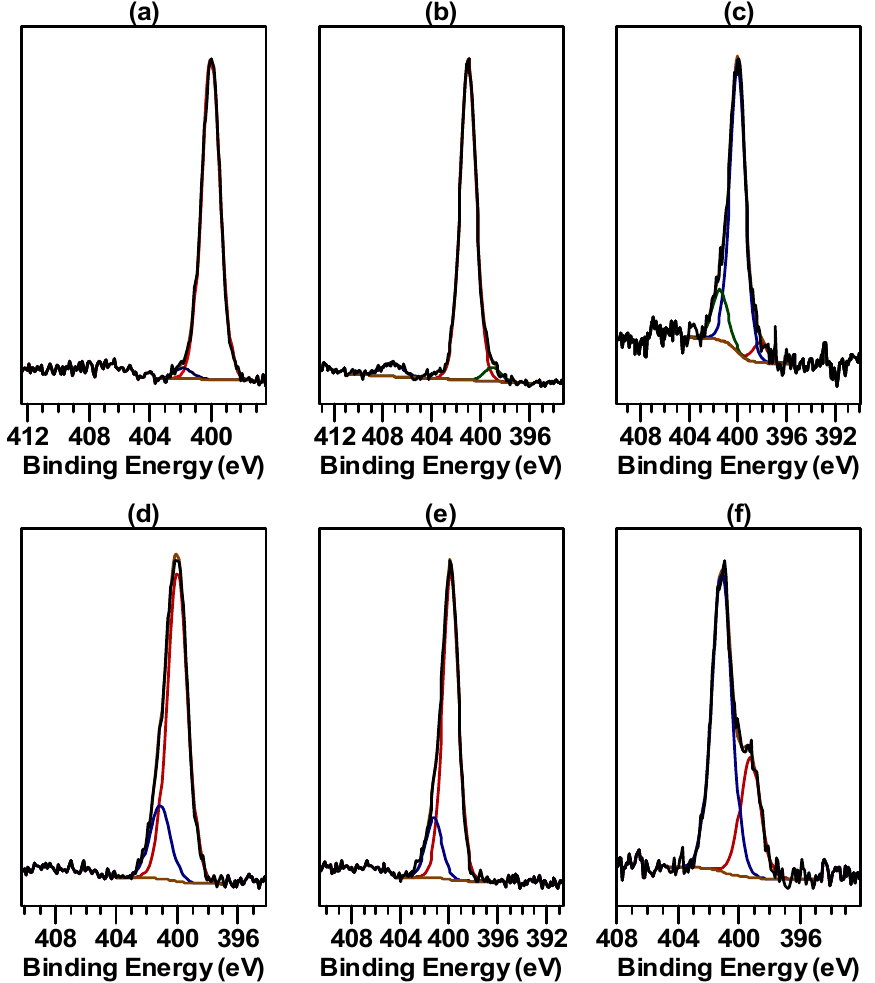
Figure 2. N 1s spectrum determined at the start of the spectral suite for: ( a ) bulk Cu hydroximate; ( b ) bulk Fe hydroxamate; ( c )–( f ) surfaces conditioned in hydroxamate collector: ( c ) Cu metal; ( d ) malachite; ( e ) pseudomalachite; ( f )